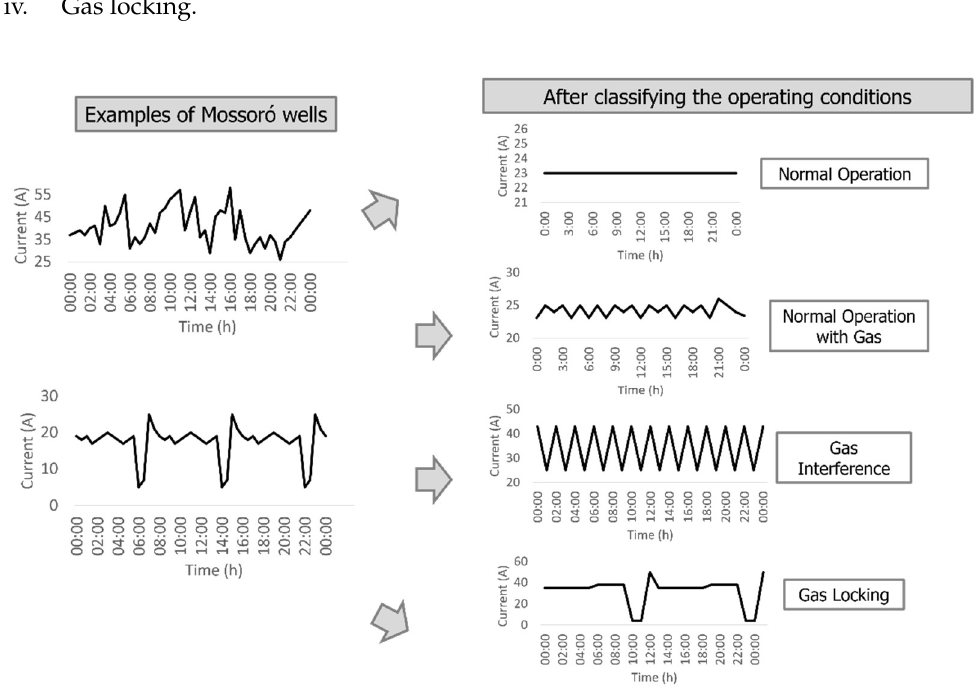
Figure 4. Classification scheme and manual selection of electric current data used in this work.